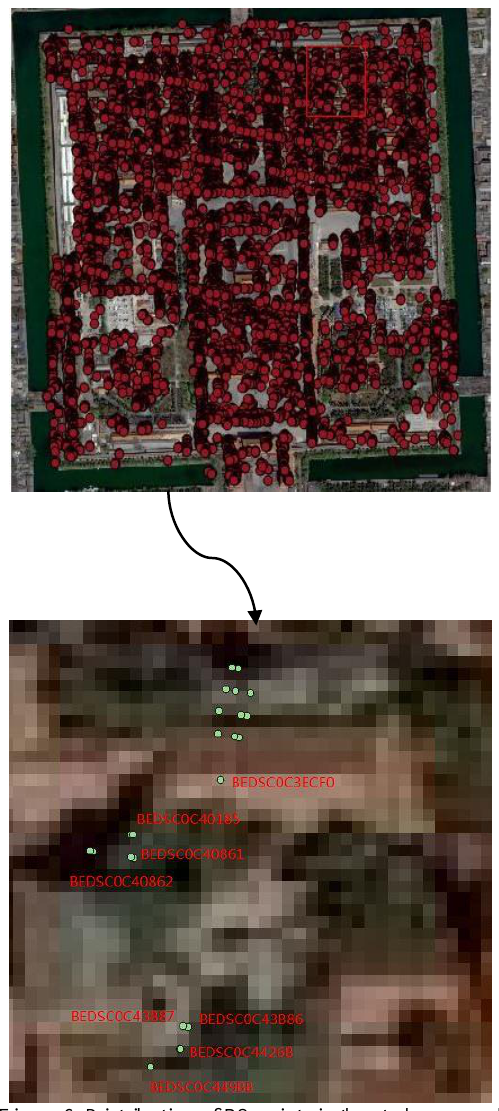
Figure 6. Distribution of PS points in the study area and Fuwangge Rockery